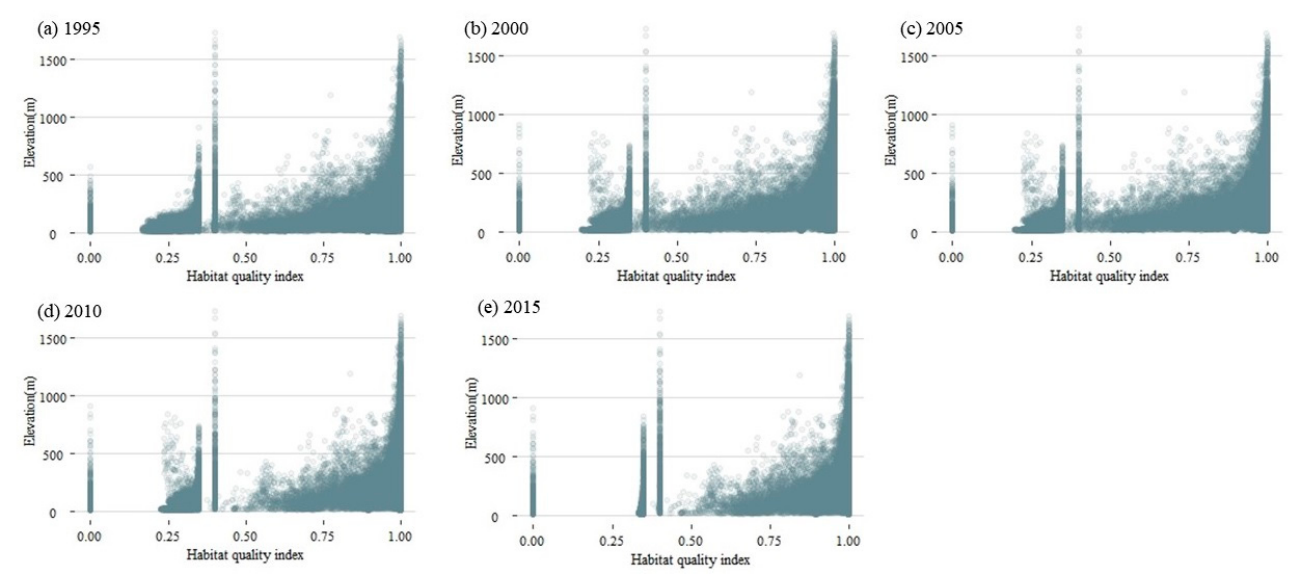
Figure 8. The numerical distribution of habitat quality at different elevations in the years ( a ) 1995, ( b ) 2000, ( c ) 2005, ( d ) 2010, and ( e ) 2015.